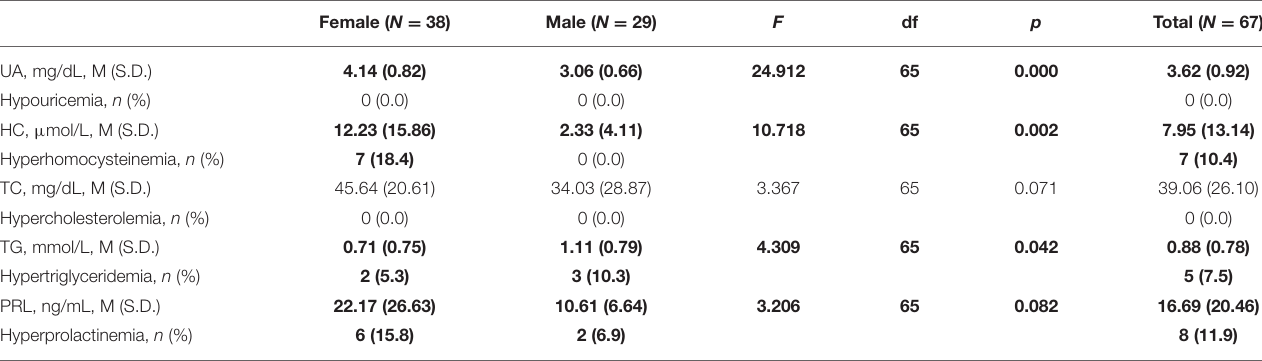
TABLE 3 | Mean baseline cognitive test scores for patients (Chengdu, China, 2018) by sex. Female ( N = 38) Male ( N = 29) F df p Total ( N = 67) MQ, M (S.D.) 57.3 (30.1) 62.7 (30.9) 0.184 65 0.472 59.6 (30.3) Verbal IQ, M (S.D.) 76.8 (33.0) 80.8 (32.1) 0.018 78.6 (32.4) Performance IQ, M (S.D.) 73.3 (32.9) Total IQ, M (S.D.) SCWT RT of Test I, s, M (S.D.) 13.3 (9.0) RT of Test II, s, M (S.D.) RT of Test III, s, M (S.D.) BACS, total score, M (S.D.) Verbal memory, M (S.D.) Digit sequencing, M (S.D.) Token motor task, M (S.D.) Verbal fluency, M (S.D.) Symbol coding, M (S.D.) 23.4 (15.5) Tower of london, M (S.D.) 37.6 (23.0)